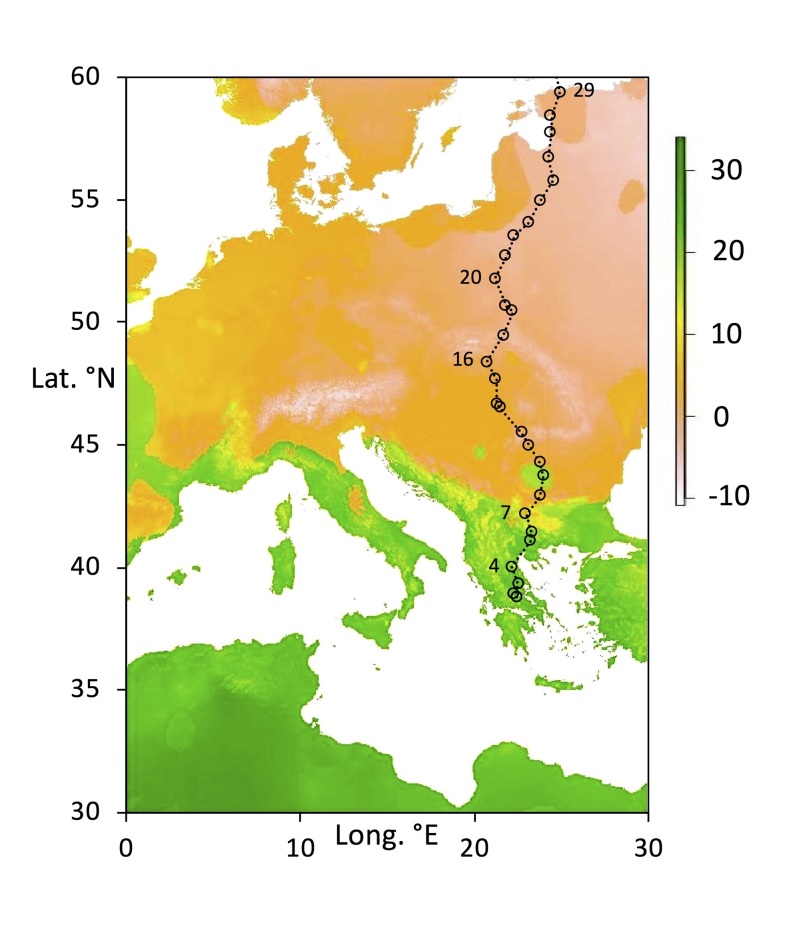
Southern sites (numbers 1 – 29; Lat. 33.80°N–59.40°N), showing the mean temperature of the driest quarter (scale in °Celsius). This parameter clearly shows the boundary of the hot and dry summer Mediterranean region (green) as opposed to winter-dry central Europe. Bioclimatic parameter (Bio9) extracted from WorldClim.